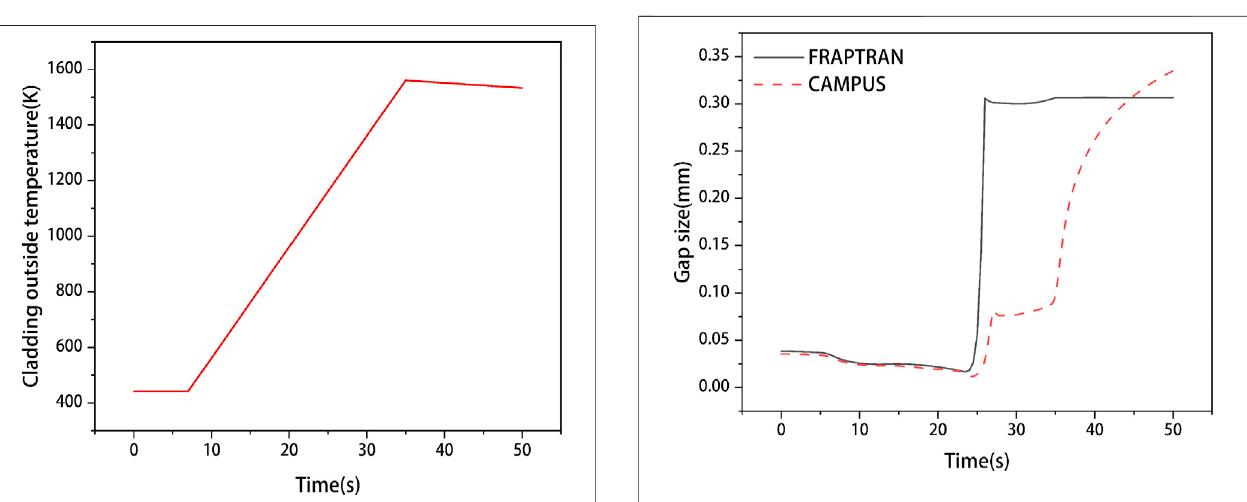
FIGURE 4 | Gap size evolutions of the UO 2 fuel with Zircaloy cladding calculated by the FRAPTRAN and CAMPUS codes under the LOCA